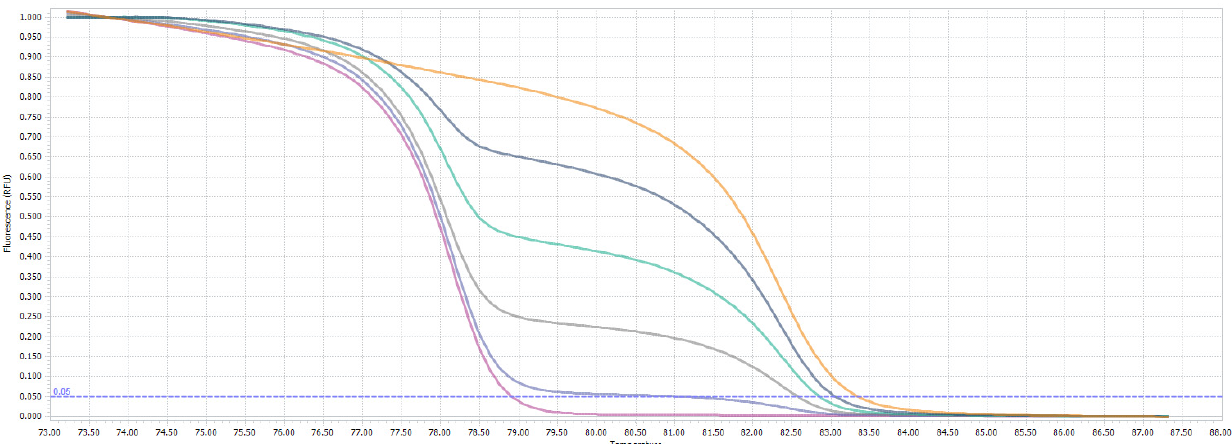
Figure 4. MS-HRM profile of ABCB1 promoter. Yellow melting curve—100% methylated standard; dark grey—75% methylated, green—50% methylated, light grey—25% methylated, blue—10% methylated, purple—unmethylated standard. For clarity, one replicate of each analyzed sample/control is shown.